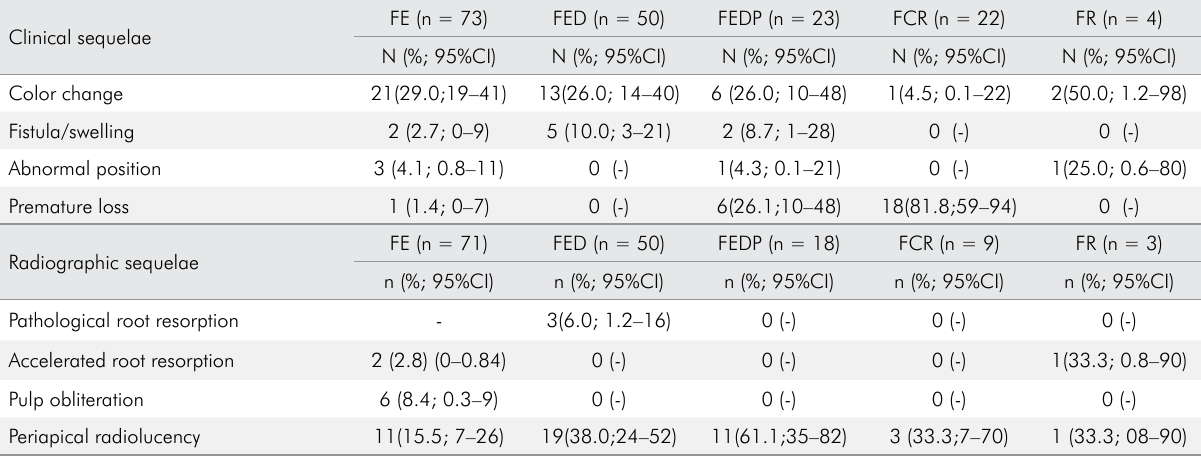
table 2. Predicted risks of sequelae, according to type of hard tissue trauma. (NETRAD). Pelotas, Brazil, 2015.